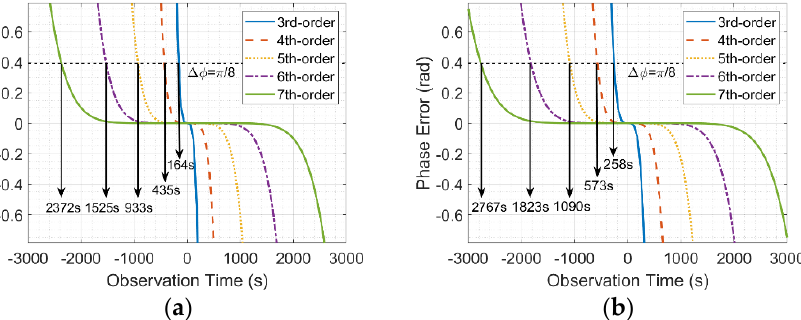
Figure 11. The maximum phase error of the whole orbit for 6000 s observation time. ( a ) “8” shaped orbit; and ( b ) a near-circular orbit.